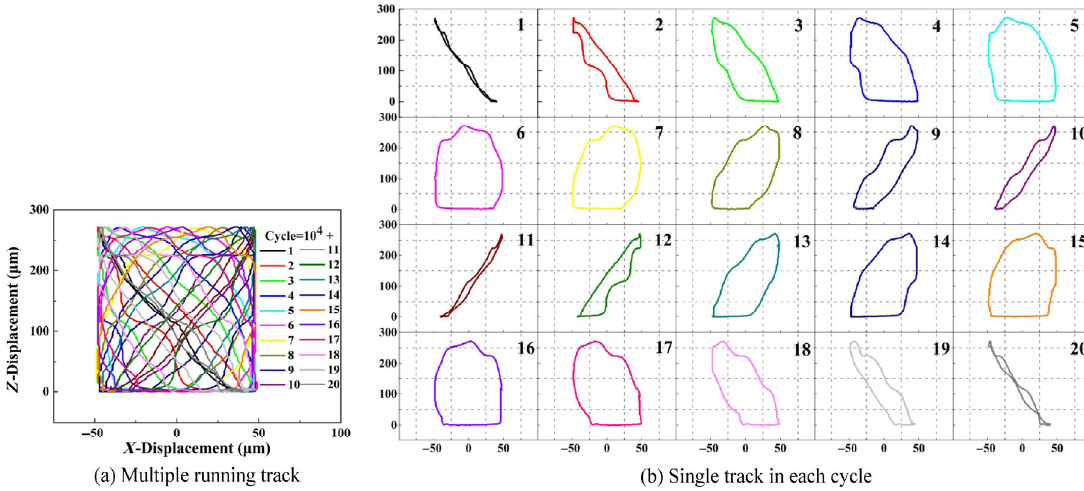
Fig. 9 Composed trajectory under multi-mode combination motion.